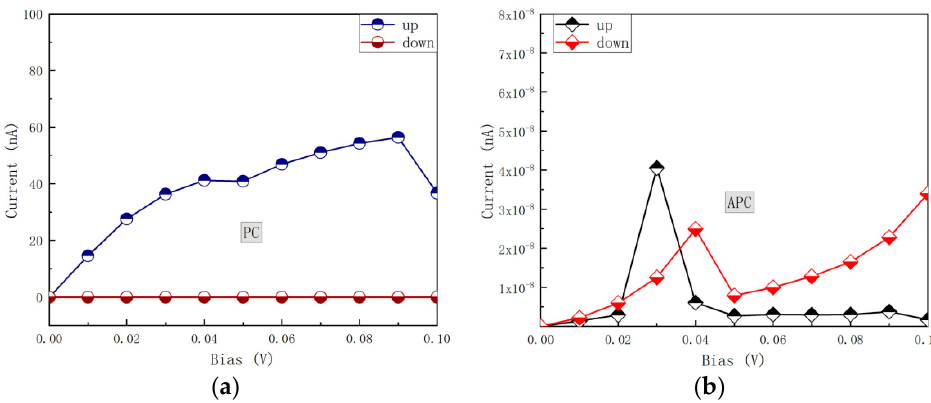
Figure 3. ( a ): Spin-dependent current in parallel configuration (PC) as a function of bias voltage for a PdF 3 based magnetic tunnel junction (MTJ). ( b ): The spin-dependent current in anti-parallel configuration (APC) as a function of bias voltage for a PdF 3 based MTJ.